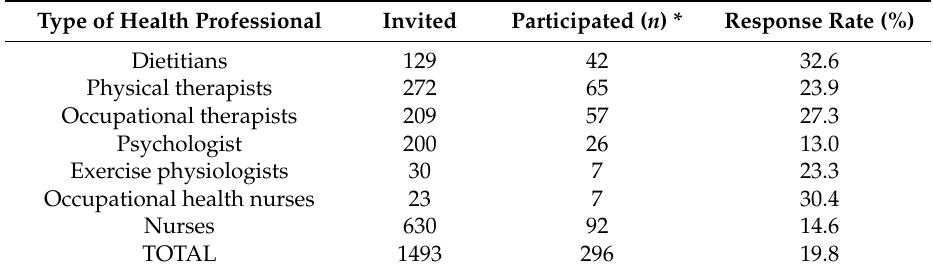
Table 1. Composition of the study sample, by allied health